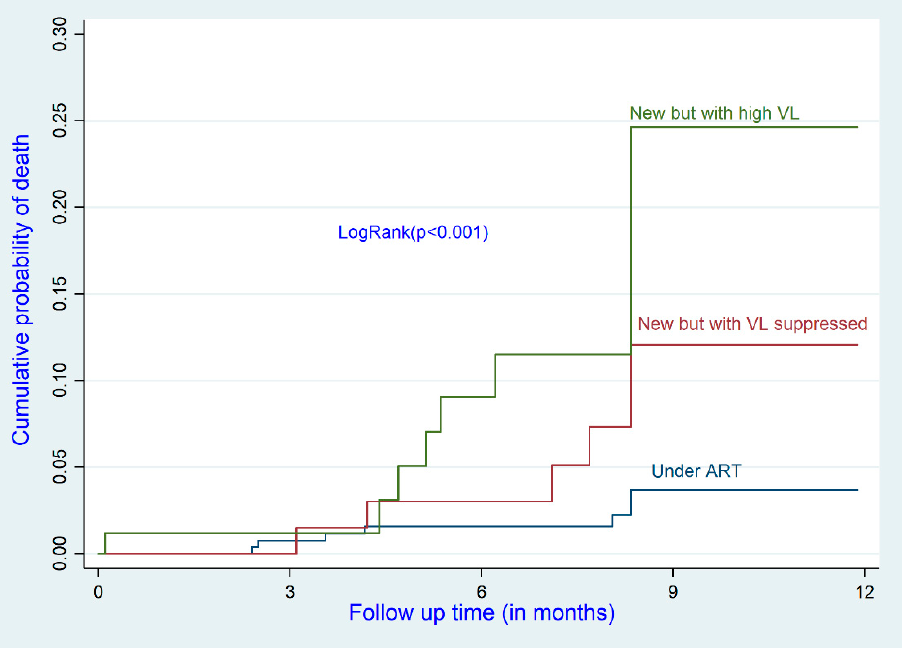
Figure 1. Cumulative incidence of death by age group.